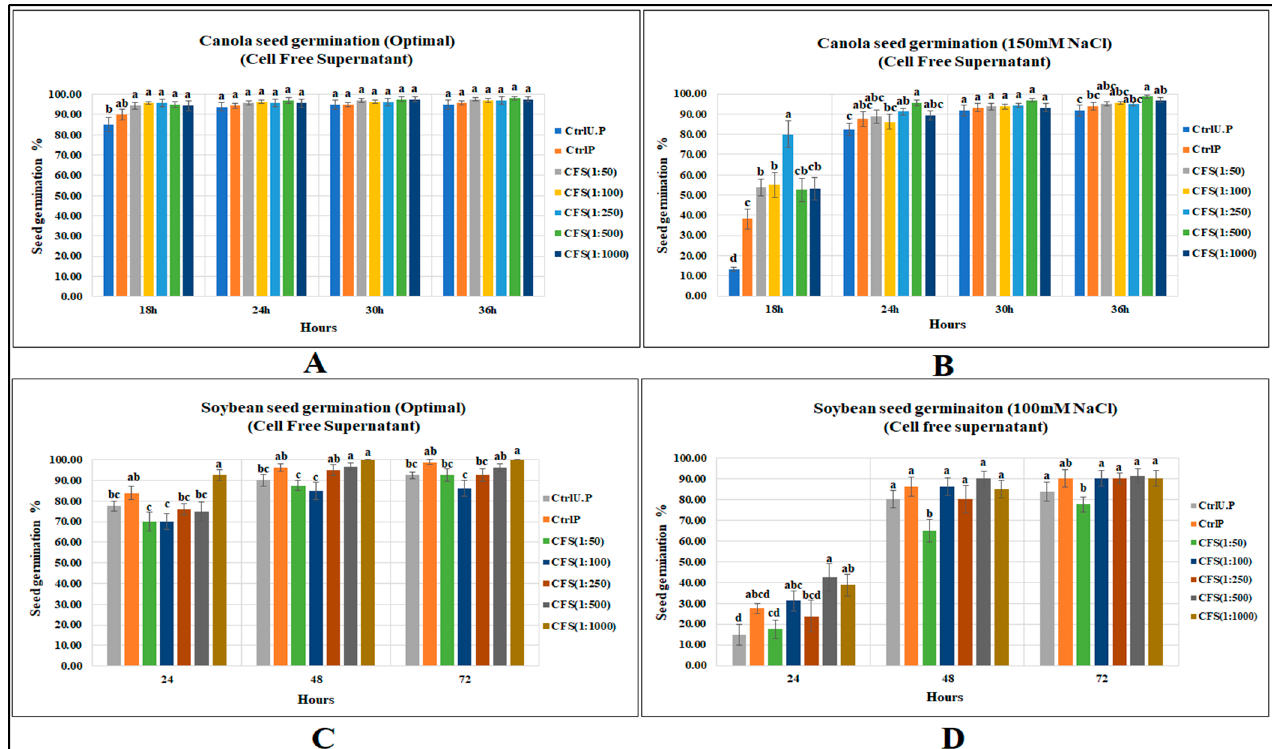
Figure 3. CFS affecting seed germination of canola and soybean: ( A ) Canola (optimal), ( B ) Canola (150 mM NaCl), ( C ) Soybean (optimal), ( D ) Soybean (100 mM NaCl). Data shown as mean ± SE of 8 biological replicates; different letters indicate values determined by Tukey’s multiple mean comparison to be significantly different ( p < 0.05) among treatments.